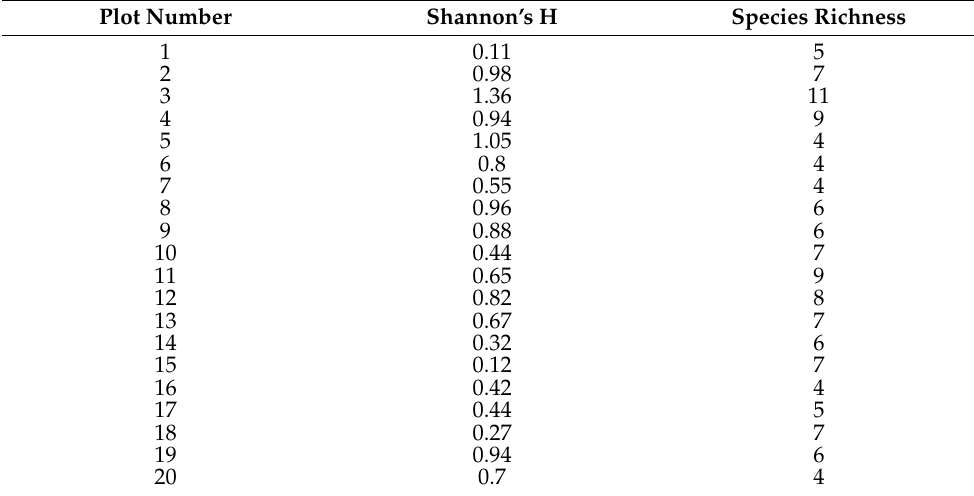
Table A1. Shannon’s H and species richness for each of the 20